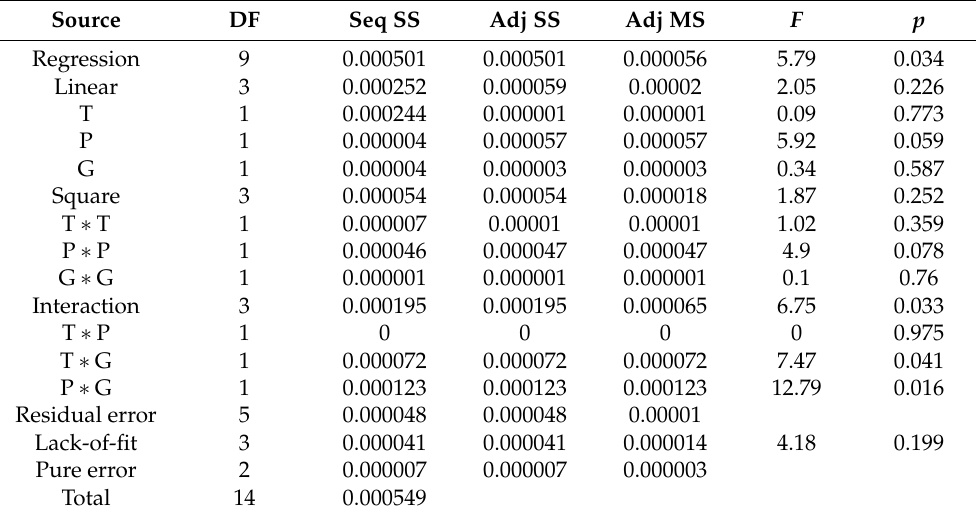
Table 4. Analysis of variance of the p -anisic acid selectivity from the crude extract. Source DF Seq SS Adj SS Adj MS